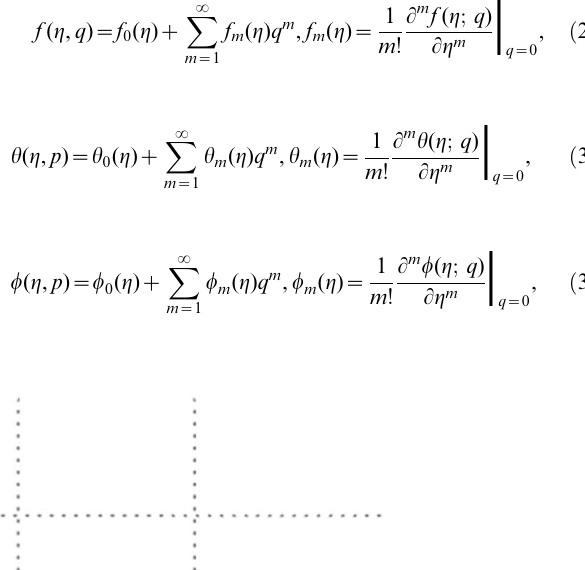
Figure 9. Influence of M on the temperature profile h ( g ) when b ~ 0 : 4 ~ Rd , l 1 ~ 0 : 5, l ~ 0 : 3 ~ N , Pr ~ 1 : 2, S ~ 0 : 2 ~ S (cid:2) and Sc ~ 1 : 0 : doi:10.1371/journal.pone.0107858.g009 where q is an embedding parameter, h (cid:2) f , h (cid:2) h and h (cid:2) w the non-zero auxiliary parameters and N f , N h and N w the nonlinear operators.